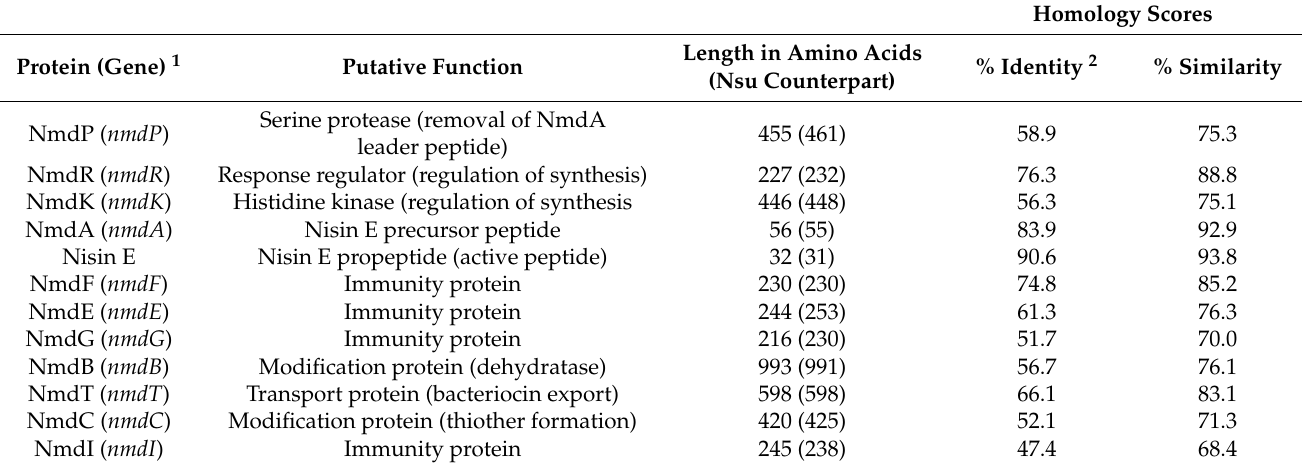
Figure 2. Predicted structures of the mature nisin U (adapted with permission from Ref. [10], 2006, John R. Tagg) and nisin E peptides. The post-translationally modified amino acids are highlighted in blue text, and the amino acid differences between nisin U and nisin E are highlighted in red text. Dha, 2,3-didehydroalanine; Dhb, 2,3-didehydrobutyrine; Lan, lanthionine; Mln, β -methyl-lanthionine. Table 3. Proteins encoded by the nmd (nisin E) locus and comparison with its Nsu (nisin U) counterparts. Homology